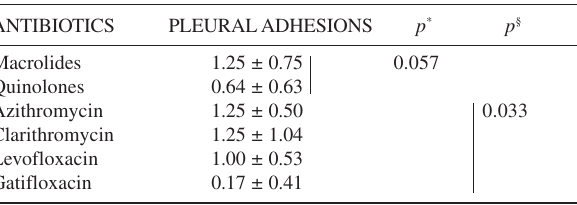
Table 2 - Scores of pleural adhesions observed macros- copically in the injected hemithorax